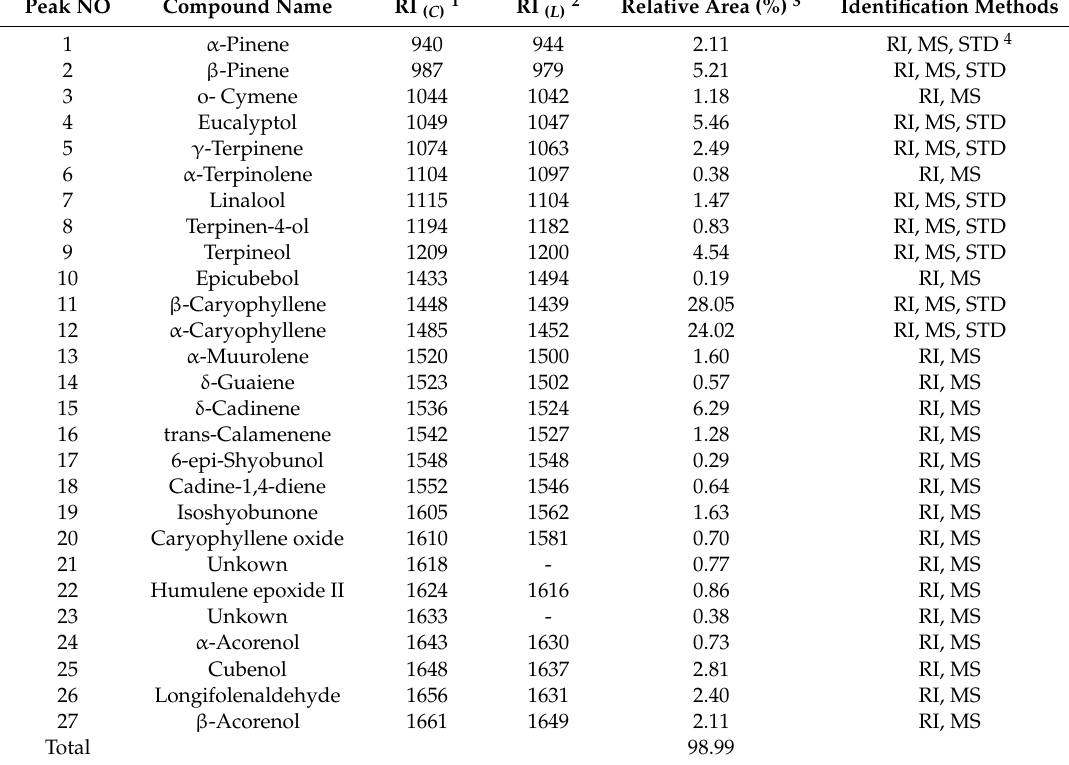
Table 1. Chemical compounds identified in the volatile supercritical fluid extraction (SFE-CO 2 ) extract of B. frutescens